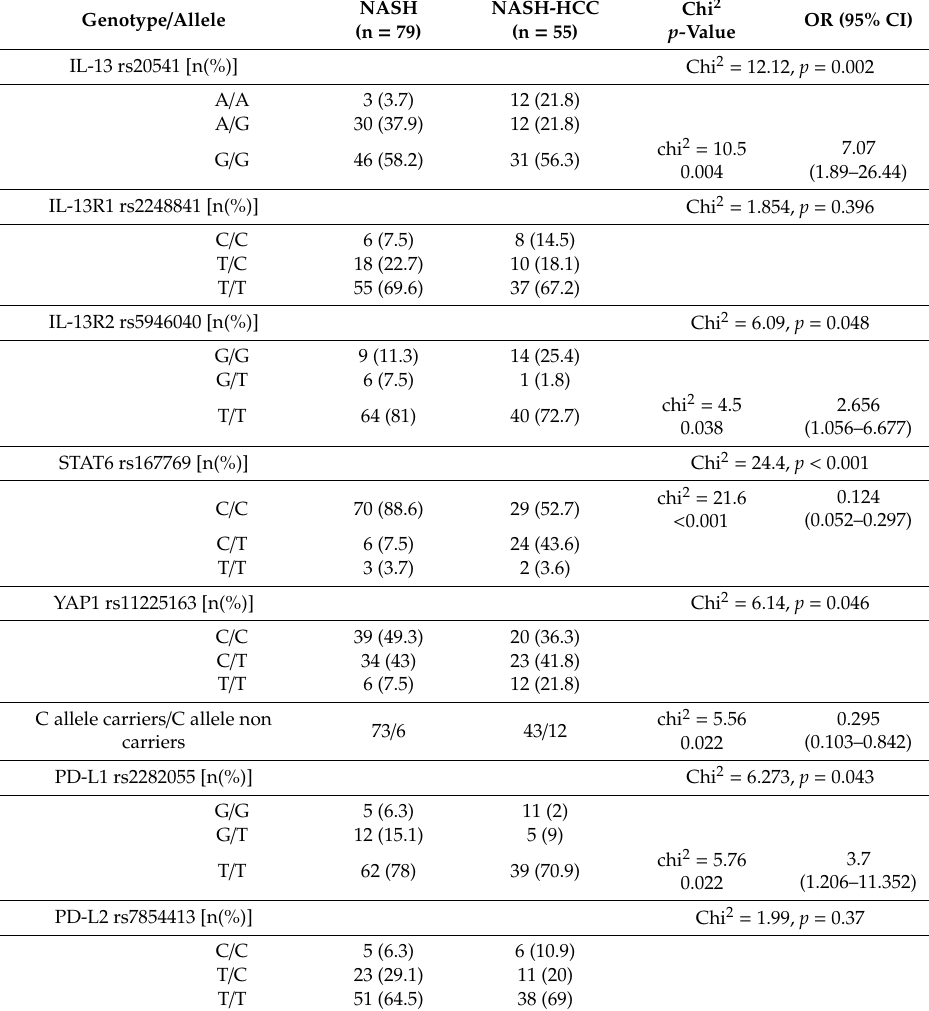
Table 2. Association of genes polymorphisms with cancer development in NASH.